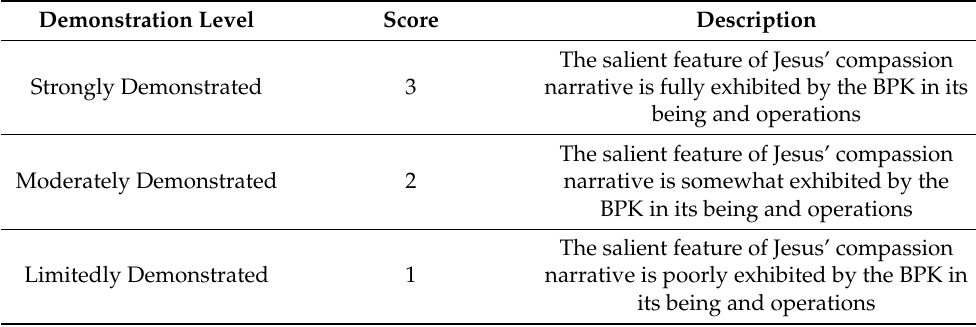
Table 2. A demonstration scale.